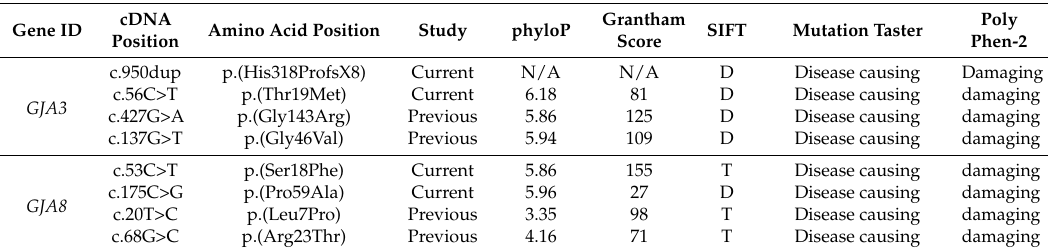
Table 1. In-silico analysis of rare variants in GJA3 and GJA8